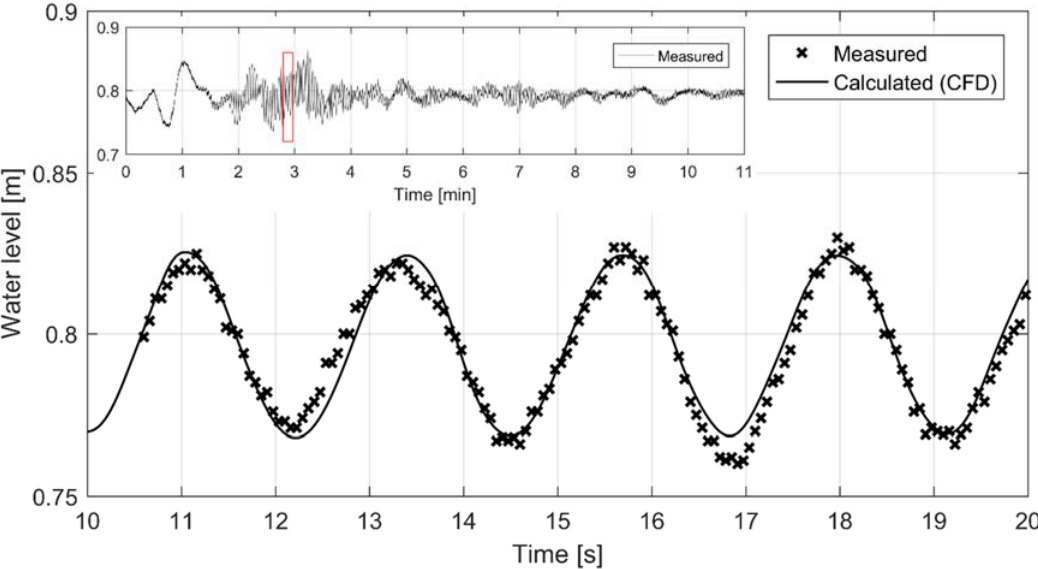
Figure 6. Measured water level fluctuations for the whole period and for the section selected for numerical modeling with the modeled values included (5.8 m from bank (ADV #3)).